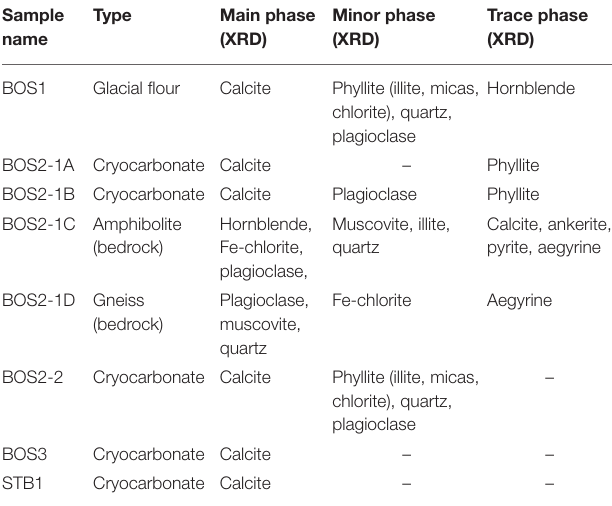
TABLE 2 | Results of the XRD mineralogical